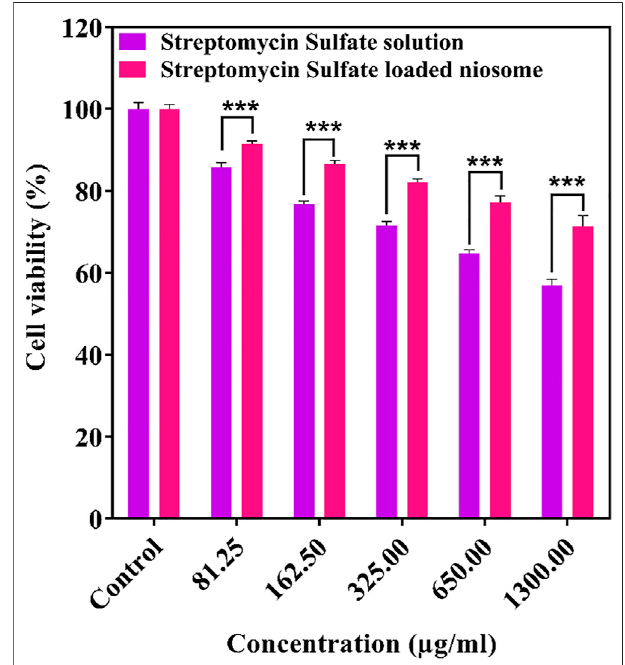
FIGURE 8 | Cytotoxicity of free and niosomal streptomycin sulfate in different concentration against HFF after 24 h. *** p < 0.001, ** p < 0.01, * p <